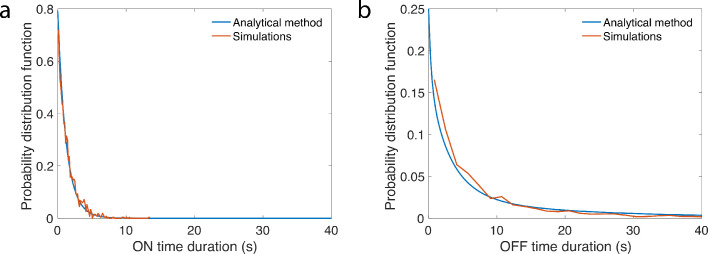
Computing gene ON and OFF times statistics for the enhancer dynamics.We check that our analytical method (see Appendix 12) properly predicts the ON (a) and OFF (b) waiting time PDF for the gene assuming a seven state promoter and a two state enhancer with independent dynamics and a gene that is ON when both the promoter and enhancer are ON. Parameters are L=1⁢μ⁢m-3, (μi)1≤i≤6=(0.2,0.8,0.15,0.4,1.2,0.7)⁢s-1, (νi)1≤i≤6=(1.3,0.2,0.4,0.6,0.7,0.8)⁢s-1, eON=0.2⁢s-1, eOFF=0.6⁢s-1.